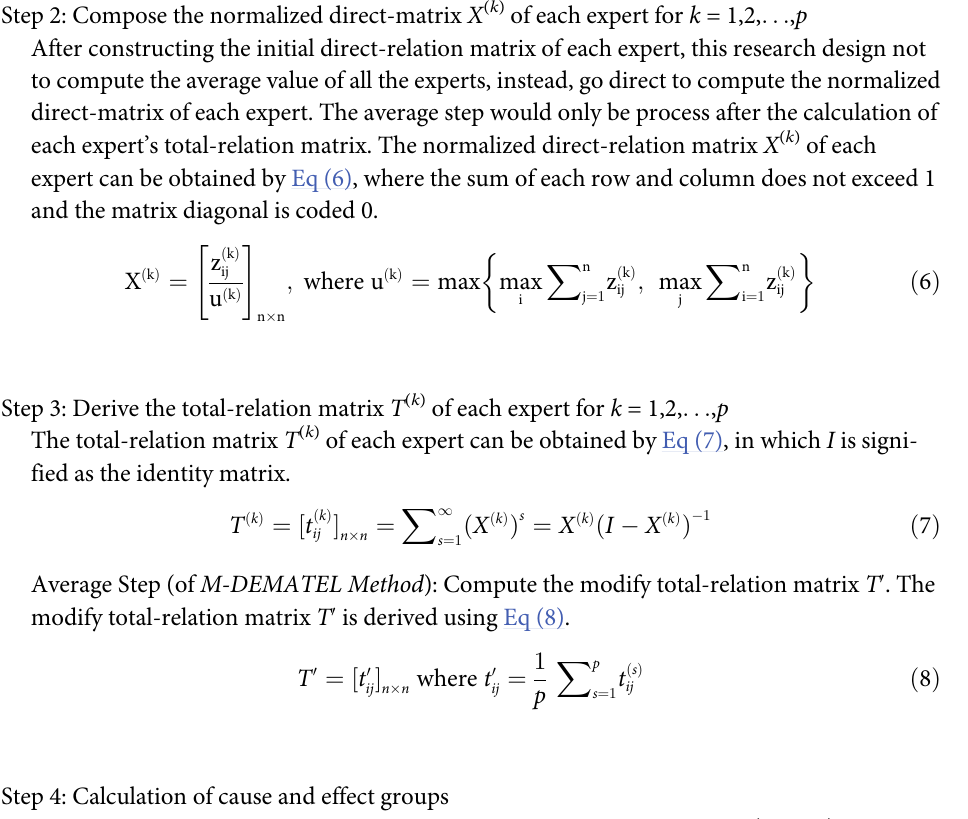
Step 4: Calculation of cause and effect groups